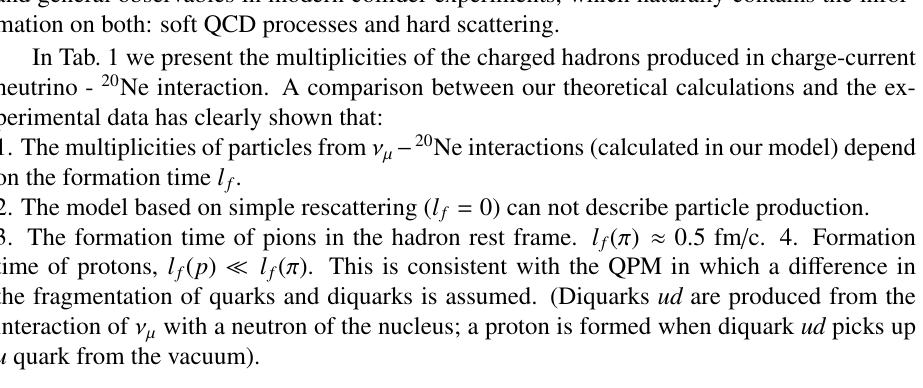
Table 1. The multiplicities of charged hadrons produced in the charge-current neutrino - 20 Ne interaction: the theory vs. experimental data. ( ∗ ) for π ± mesons and protons with p p ≥ 1 GeV / c, ( ∗∗ ) for protons with 0 . 35 ≤ p p ≤ 0.8 GeV / c. The experimental data are taken from [6–8, 13]